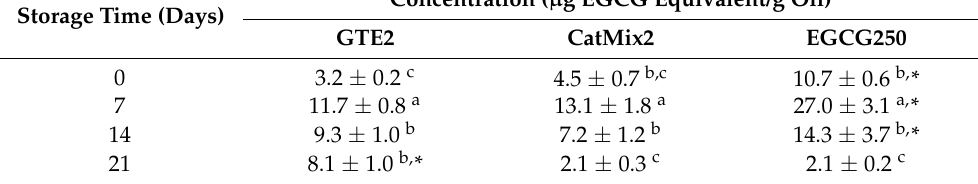
Values are mean ± SD (n = 3). Significant differences ( p ≤ 0.05) within columns are represented by different lower-case letters (a-c). * indicates a significant difference ( p ≤ 0.05) between treatments at a specific storage time (within row). GTE2 = DHA-rich oil + 450 ppm GTE2, CatMix2 = DHA-rich oil + reconstituted catechin mixture of GTE2, EGCG250 = DHA-rich oil + 250 ppm EGCG. The day 0 and 7 extracts from the EGCG250-supplemented oil injected on HPLC were two times more diluted than GTE2 and